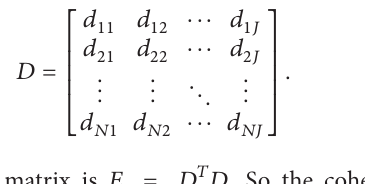
associated with the southern Oklahoma aulacogen [26,